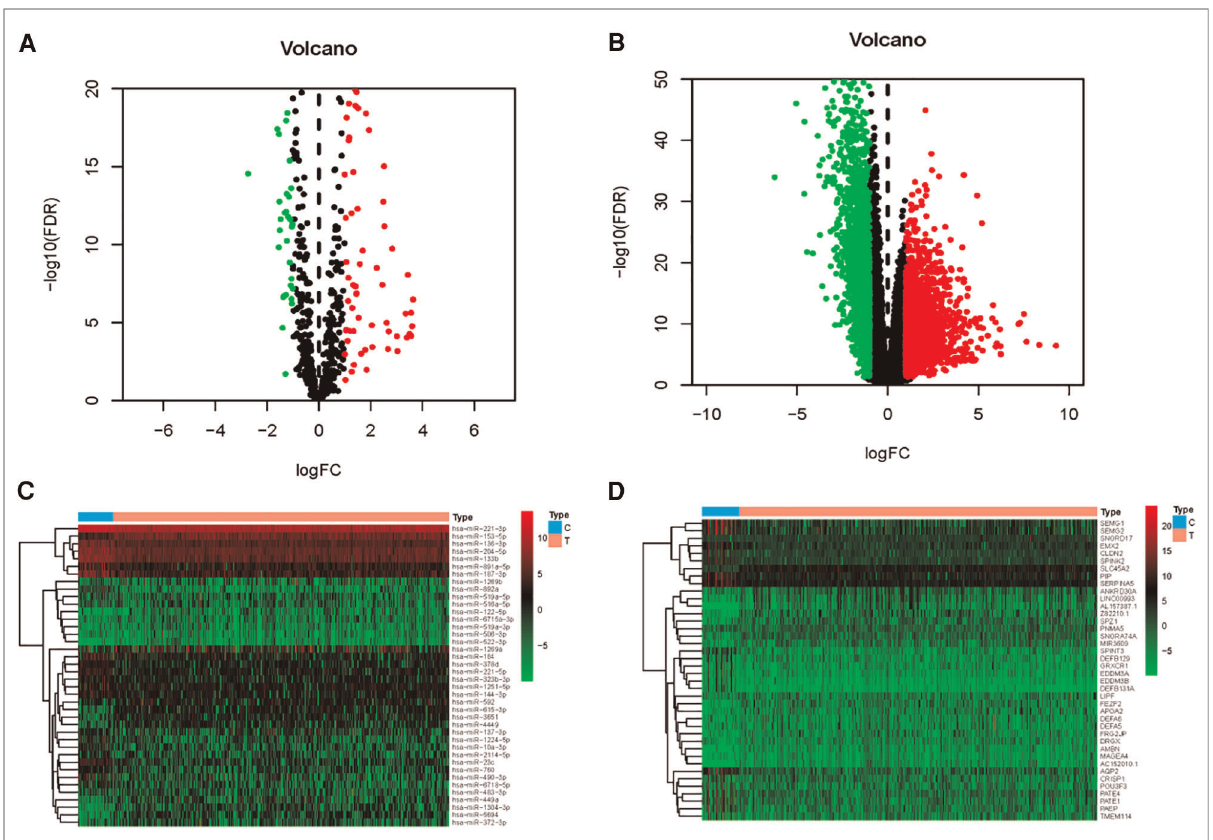
FIGURE 1 Differentially expressed miRNAs and mRNAs of PCa. Volcano plot ( A ) and heatmap ( C ) showing the differential expression miRNAs of PCa tissues and adjacent-normal tissues. Volcano plot ( B ) and heatmap ( D ) demonstrating differentially expressed mRNAs of PCa and adjacent tissues. FDR<0.05, log 2 | FC |>1 and p <0.05.